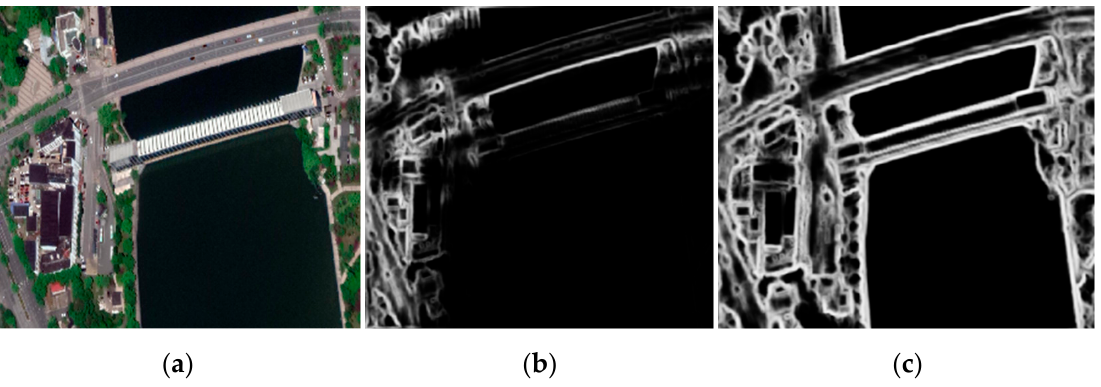
Figure 4. Comparison between HED and improved HED network. ( a ) Original image of dam; ( b ) HED image of dam; ( c ) improved HED network image of